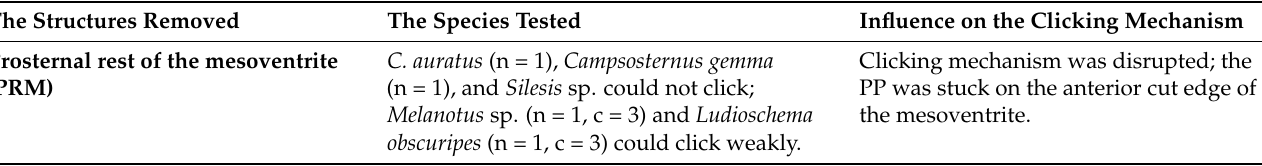
Table 3. The influences of destructions of sclerites on the clicking mechanism in